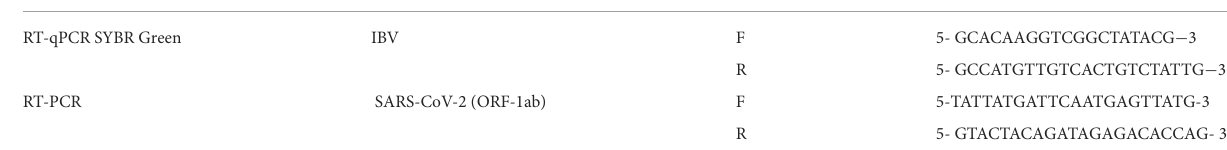
TABLE 2 Primers of PCR assay used in this study.